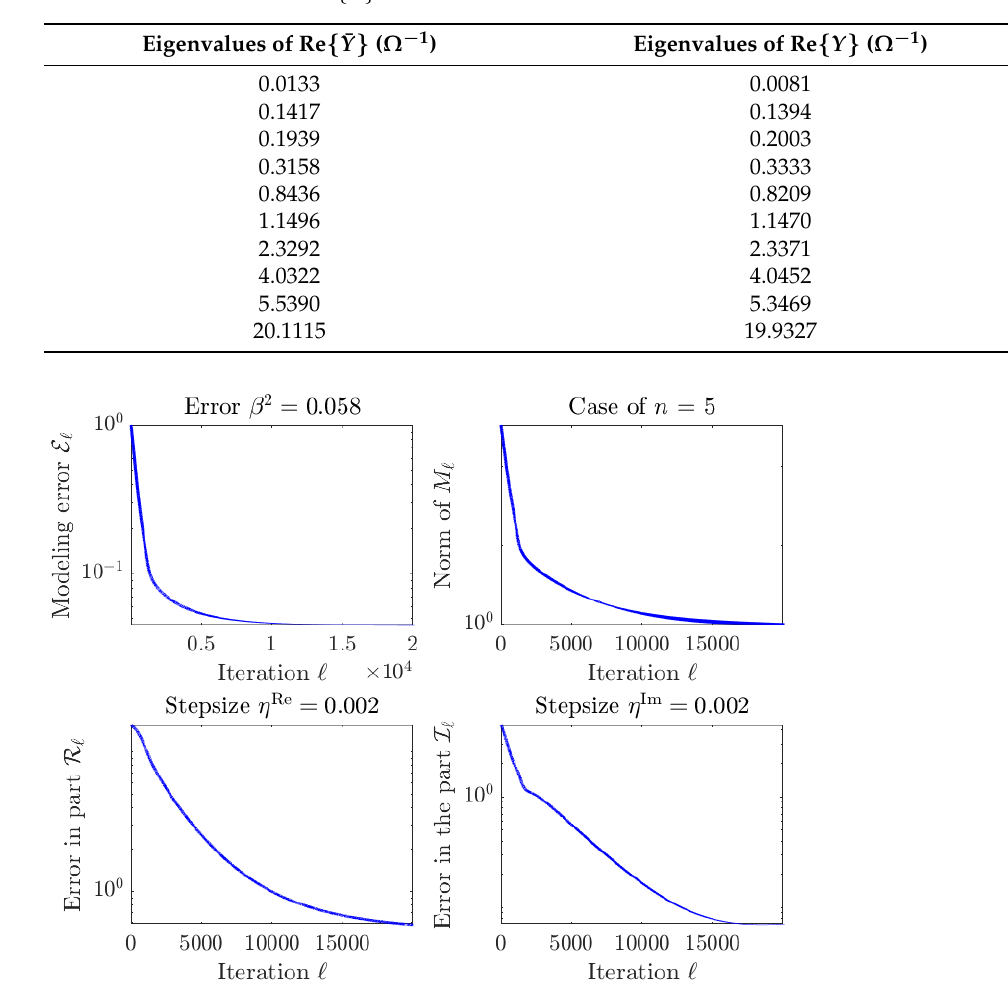
Table 3. Eigenvalues of the estimated conductance matrix Re { Y } compared to the eigenvalues of the actual conductance matrix Re { ¯ Y } in the case n = 5.